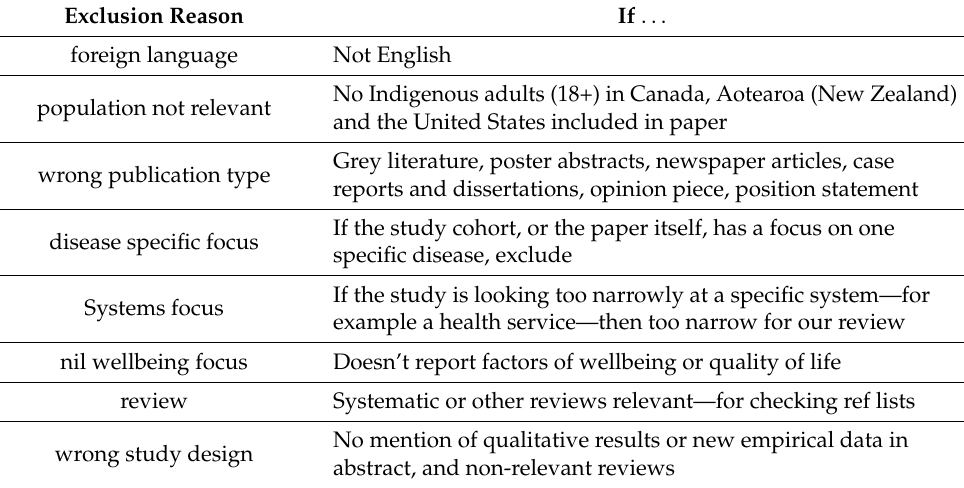
Table A1. Hierarchy table used to exclude articles and improve consistency of